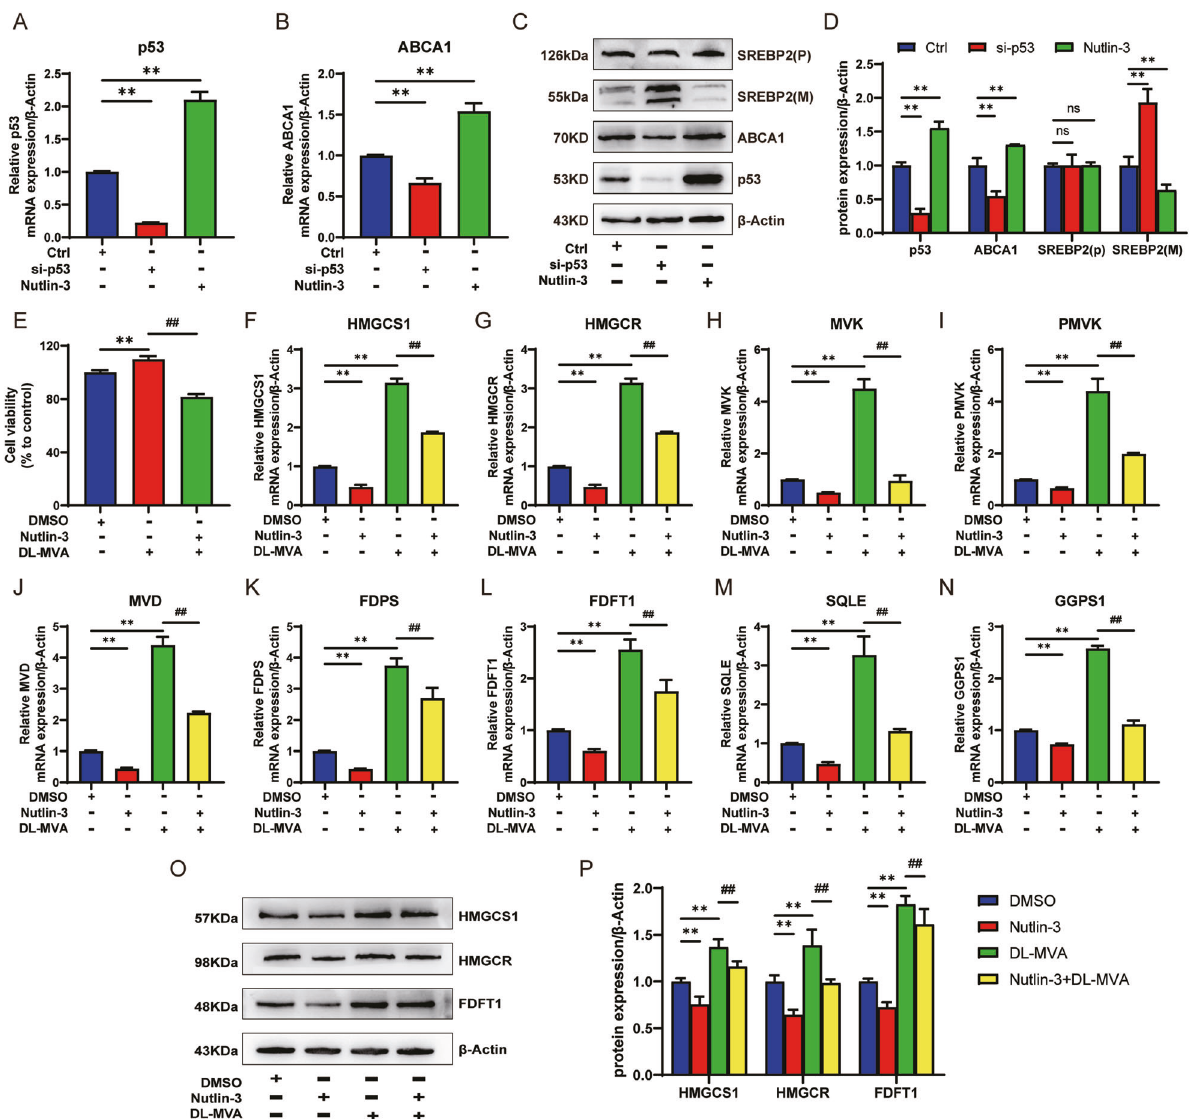
Fig. 2 Effect of p53 on the MVA pathway in A549 cells. A549 cells treated with si-p53 or Nutlin-3, RT-qPCR could detect the relative mRNA expression of p53 ( A ) and ABCA1 ( B ). p53, ABCA1, SREBP2(P), SREBP2(M) protein expression using western blotting ( C ) and the bar graph corresponding to C after statistical analysis ( D ) in A549 cells treated with si-p53 or Nutlin-3. E The relative mRNA expression of the MVA pathway genes HMGCS1 ( F ), HMGCR ( G ), MVK ( H ), PMVK ( I ), MVD ( J ), FDPS ( K ), FDFT1 ( L ), SQLE ( M ), and GGPS1 ( N ) by RT-qPCR in A549 cells treated with Nutlin-3 combined with DL-MVA or Nutlin-3 alone or DL-MVA alone. The expression of the MVA pathway key proteins HMGCS1, HMGCR, and FDFT1 using western blotting ( O ) and the bar graph corresponding to O ( P ) in A549 cells treated with Nutlin-3 combined with DL-MVA or Nutlin-3 alone or DL-MVA alone. The above bar graphs were the sum of 3 independent experiments (mean ± SD). The ctrl group was A549 cells treated with a medium solution containing si-p53 NC and DMSO, ns: not signi fi cant, * P < 0.05 and ** P < 0.01 vs. Ctrl or DMSO group, # P < 0.05 and ## P < 0.01 vs . DL-MVA